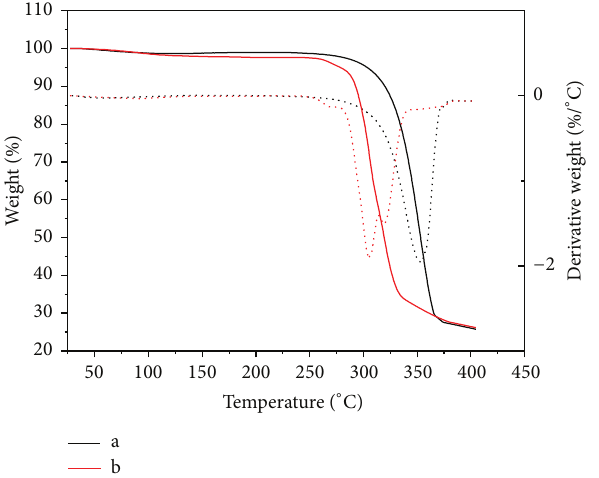
Figure 4: The TG and DTG curves of UMCF (a) and CMCF (b).